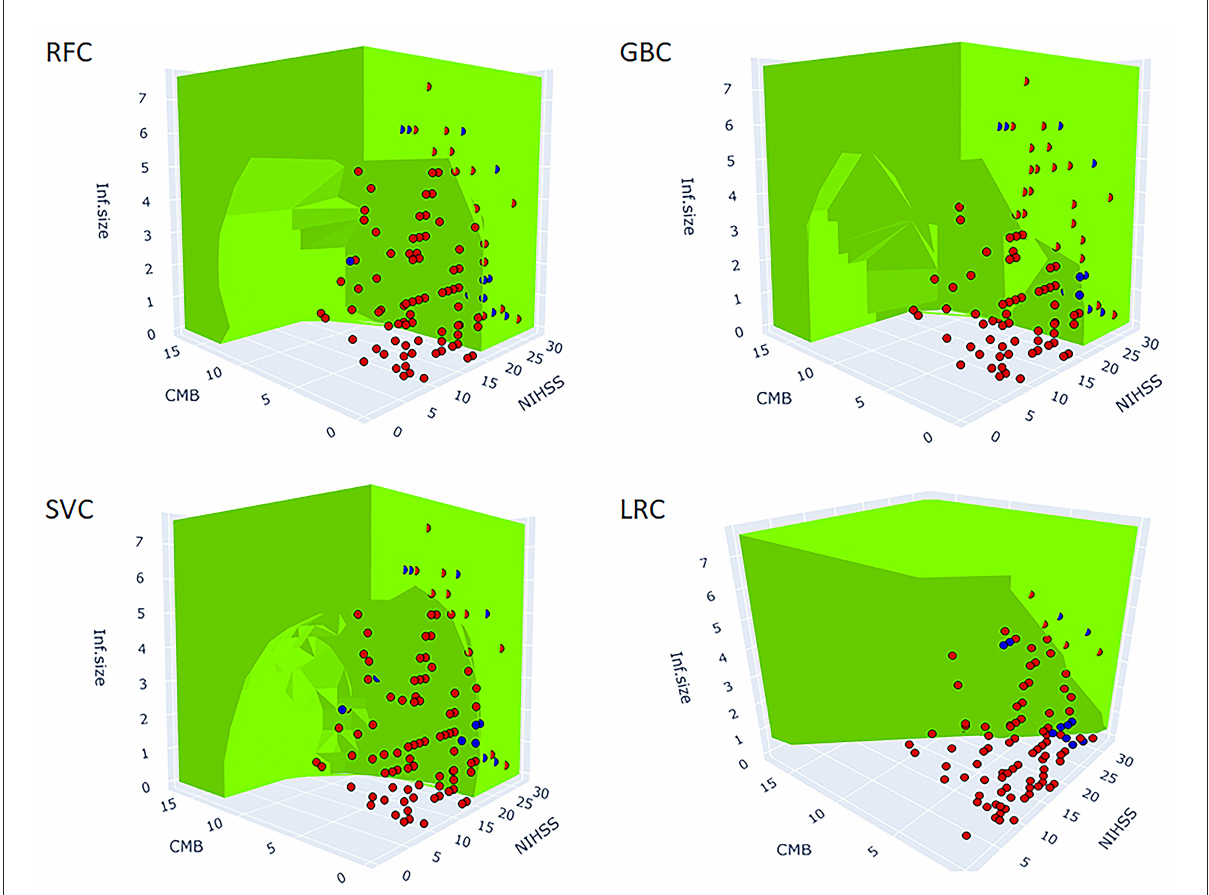
FIGURE3 3D figure shows the predicted spaces of each ML model within the true feature space. The green area represents the positive HT prediction, while the non-colored area represents the negative prediction. The blue and red dots represent the observed positive and negative HT cases, respectively (the points inside the green predicted space are not visible). The blue dots within the green and clear areas represent true positive and false negative predictions, respectively. The red dots within the green and clear areas represent false positive and true negative predictions, respectively. The best performing models, RFC, GBC, and SVC reveal non-linear decision boundaries indicative of the interaction between the three predictors. At a particular value of NIHSS, observe the reduction of infarction size needed for HT prediction to be green (positive) as the number of CMB increases. Similarly, at a particular value of CMB, observe the reduction of infarction size needed for HT prediction to be green as the NIHSS score increases. LRC did not capture the non-linear relationships and as such, it failed to model the interaction between predictors. The MLPC was not considered for 3D model presentation because of its very low sensitivity. SVC, support vector classifier; GBC, gradient boosting classifier; LRC, logistic regression classifier; RFC, random forest classifier; MLPC, multilayer perceptron